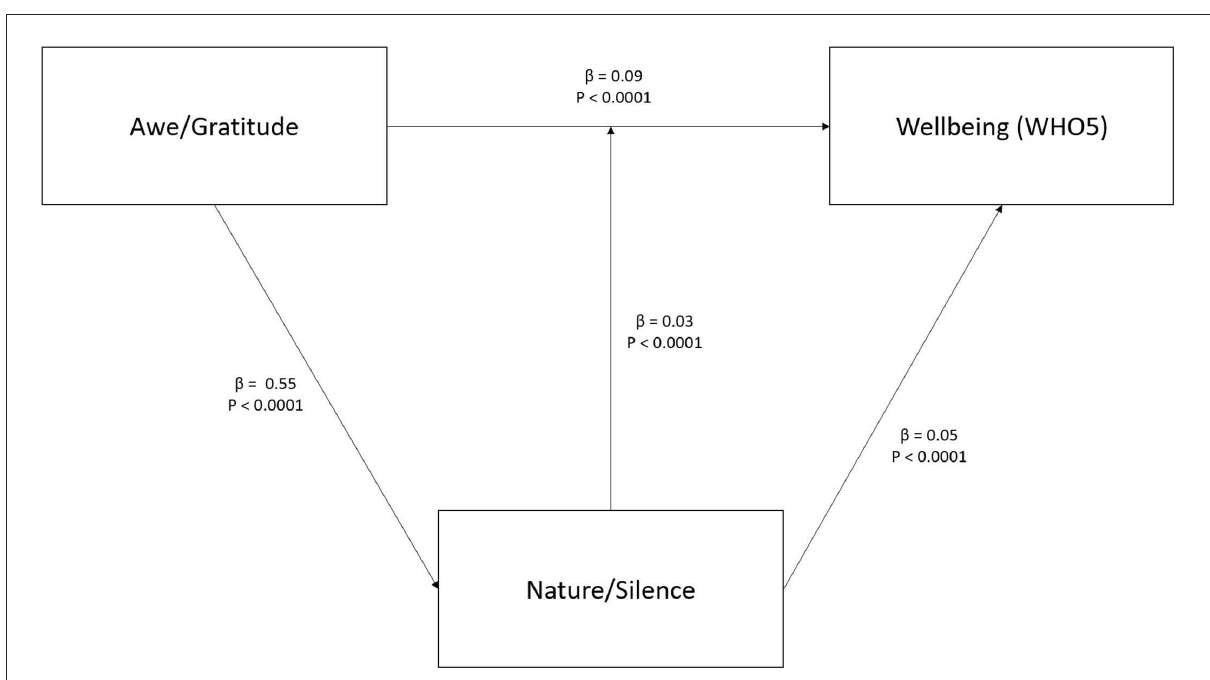
FIGURE2 Mediation analysis with Nature/Silence as mediator between Awe/Gratitude and wellbeing. Depicted are standardized beta values with